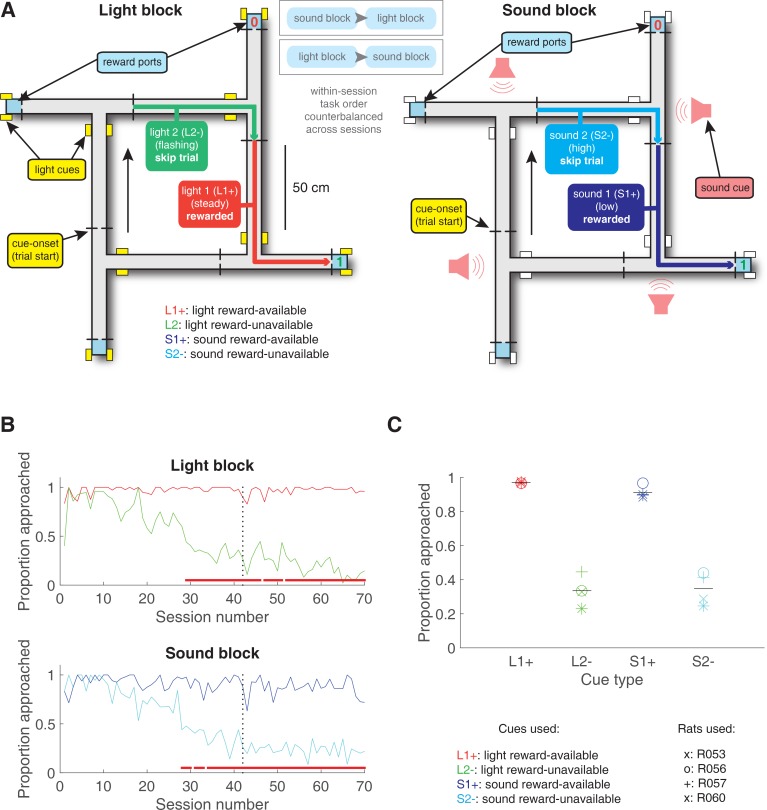
Schematic and performance of the behavioural task.(A) Apparatus was a square track consisting of multiple identical T-choice points. At each choice point, the availability of 12% sucrose reward at the nearest reward receptacle (light blue fill) was signalled by one of four possible cues, presented when the rat initiated a trial by crossing a photobeam on the track (dashed lines). Photobeams at the ends of the arms by the receptacles registered nosepokes. Arrows outside of track indicate correct running direction. Left: light block showing an example trajectory for a correct reward-available (approach trial; red) and reward-unavailable (skip trial; green) trial. Rectangular boxes with yellow fill indicate location of LEDs used for light cues. Right: sound block with a correct reward-available (approach trial; navy blue) and reward-unavailable (skip trial; light blue) trial. Speakers for sound cues were placed underneath the choice points, indicated by magenta speaker icons. Ordering of the light and sound blocks was counterbalanced across sessions. Reward-available and reward-unavailable cues were presented pseudo-randomly, such that not more than two of the same type of cue could be presented in a row. Location of the cue on the track was irrelevant for behaviour, all cue locations contained an equal amount of reward-available and reward-unavailable trials. (B-C) Performance on the behavioural task. B. Example learning curves across sessions from a single subject (R060) showing the proportion of trials approached for reward-available (red line for light block, navy blue line for sound block) and reward-unavailable trials (green line for light block, light blue line for sound block) for light (top) and sound (bottom) blocks. Fully correct performance corresponds to an approach proportion of 1 for reward-available trials and 0 for reward-unavailable trials. Rats initially approach on both reward-available and reward-unavailable trials, and learn with experience to skip reward-unavailable trials. Red bars indicate days in which a rat statistically discriminated between reward-available and reward-unavailable cues, determined by a chi square test. Dashed line indicates time of electrode implant surgery. (C) Proportion of trials approached for each cue, averaged across all recording sessions and shown for each rat. Different columns indicate the different cues (reward-available (red) and reward-unavailable (green) light cues, reward-available (navy blue) and reward-unavailable (light blue) sound cues). Different symbols correspond to individual subjects; horizontal black line shows the mean. All rats learned to discriminate between reward-available and reward-unavailable cues, as indicated by the clear difference of proportion approached between reward-available (∼90% approached) and reward-unavailable cues (∼30% approached), for both blocks (see Results for statistics).